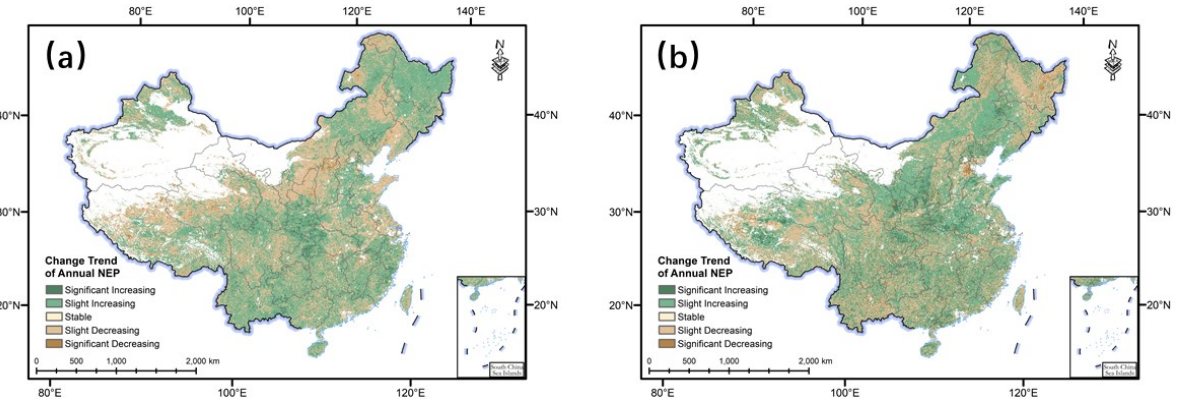
Figure 2. Change trends of the terrestrial net ecosystem productivity (NEP) in China from 1981 to 1999 ( a ) and from 2000 to 2018 ( b ).